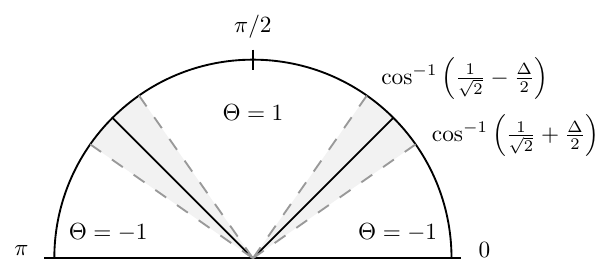
FIG. 18. A depiction of a finite-sized (cid:16) region and the result- ing values of (cid:15) . The shaded regions indicate where the appli- cation of the QSVT sequence returns an indeterminate mea- surement result (equivalently, where the sign function is poorly